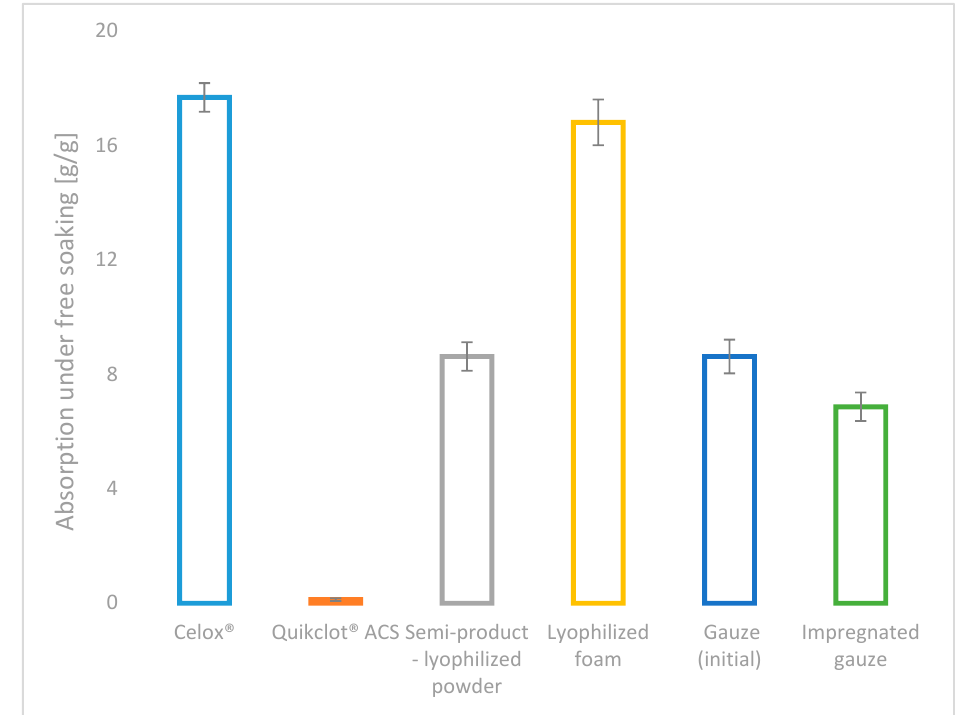
Figure 3. Absorption under free soaking of the references: Celox ® , Quikclot ® ACS, semi-product—lyophilized powder [15] or gauze and the studied usable forms of the haemostatic agents: lyophilized foam and impregnated gauze.